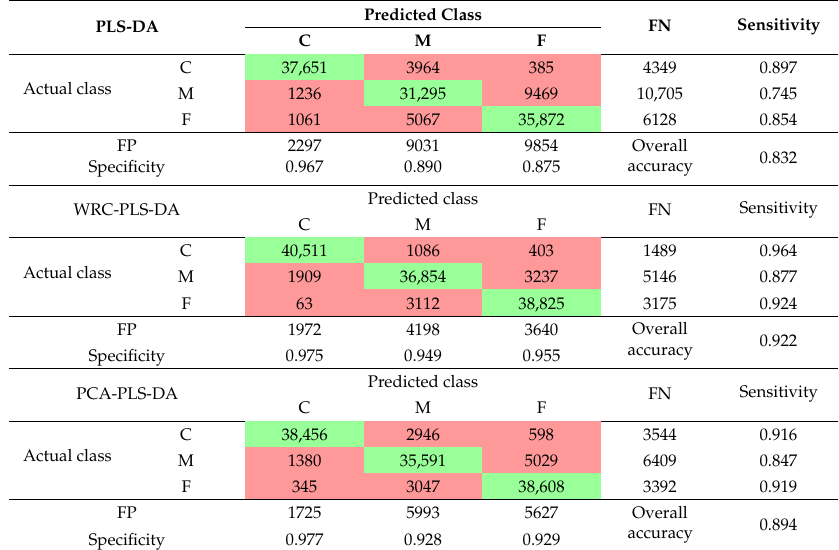
Table 2. Classification performance of models for prediction of particle size fraction of milk powder.